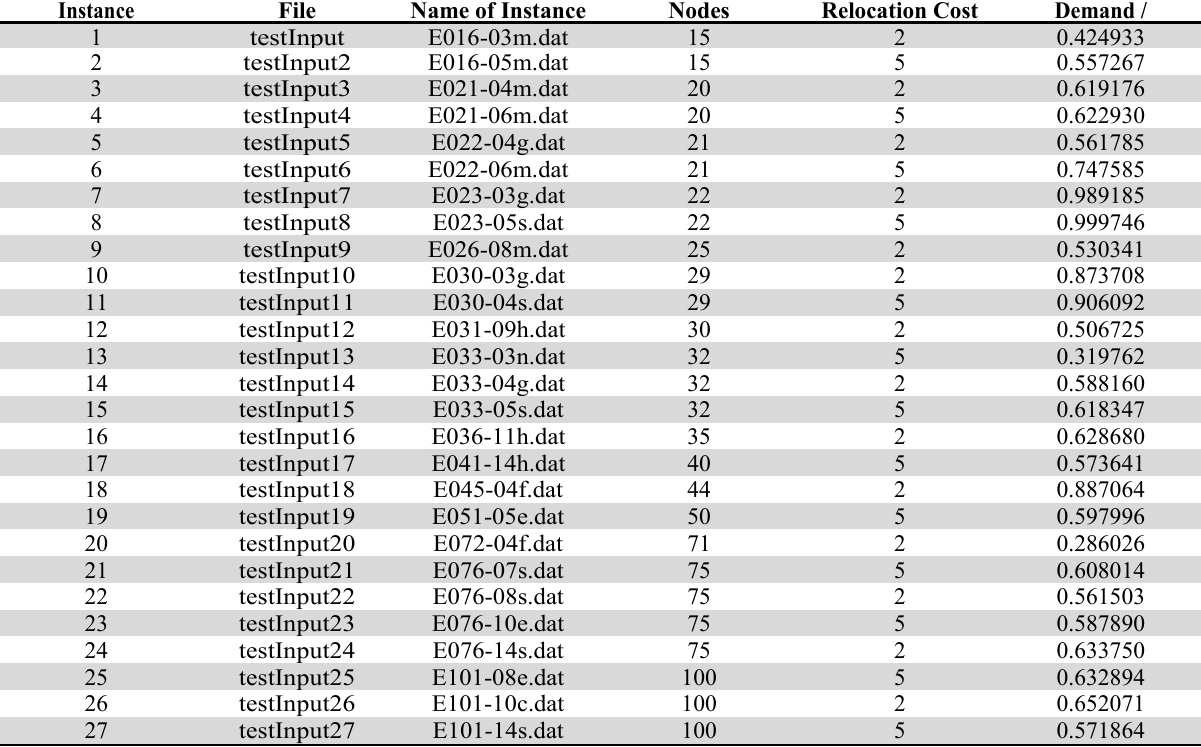
Information of Instances generated for